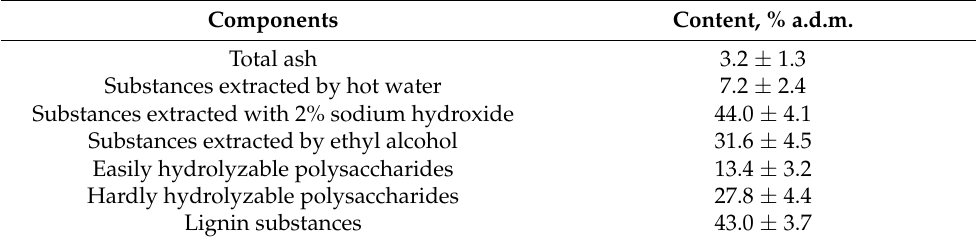
Table 5. Chemical composition of the bark of Pinus sylvestris L. [106].